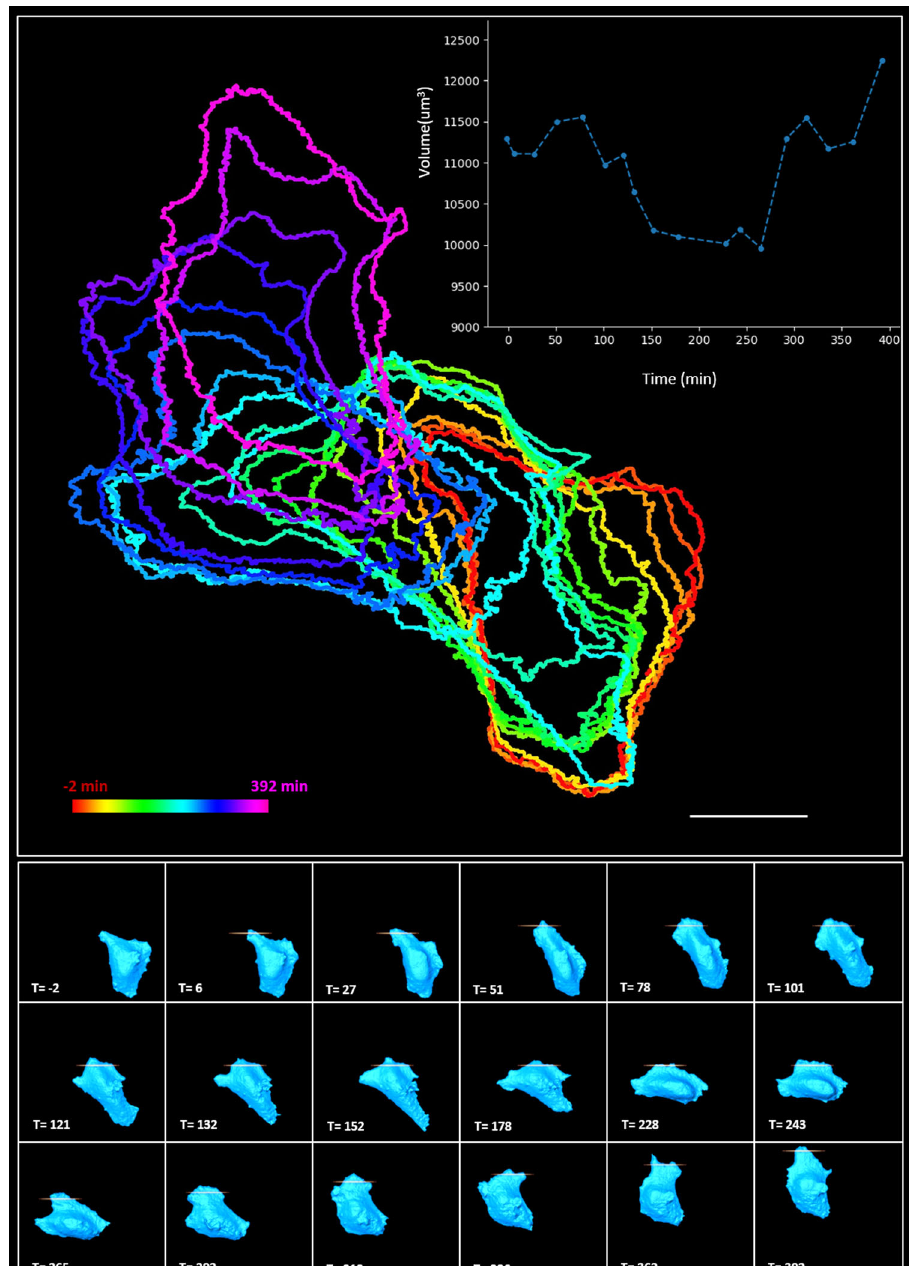
Fig. 5 The time-dependent trajectories of the cell in the guided migration experiment. The cell expressing EGFR-CRY2olig-mApplex3 was stimulated by a 1 nW Bessel fan. Different colors represent different time points. The individual LLSM 3D rendering images of the cell at different times, and the stimulated areas are depicted at the bottom. The volume changes of the cell during the cell-guided migration are plotted in the inset. The interval between each stimulation and image is about 1 min. The entire experiment lasted 392 min. Scale bar 20 μ